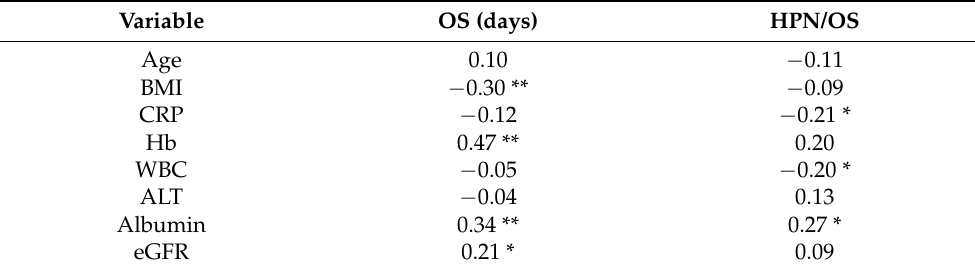
Table 3. Spearman rank-order correlations of survival and relative total and home parenteral nutrition times with initial clinical and laboratory